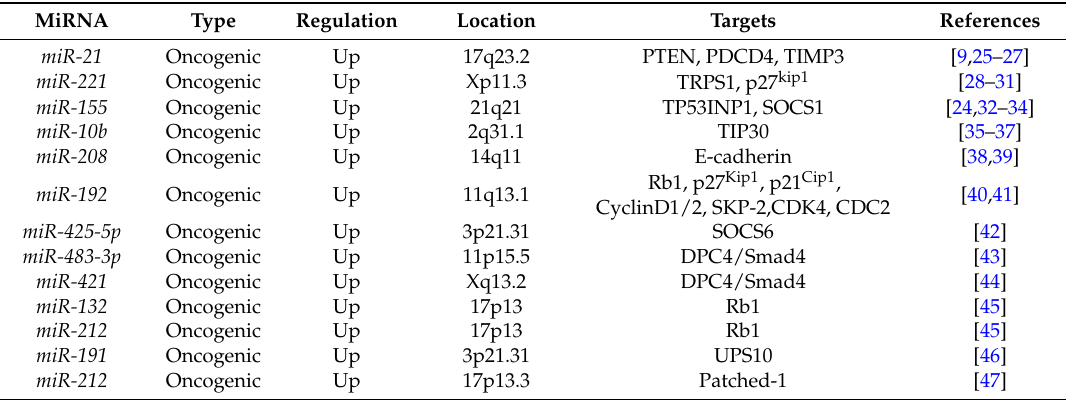
Table 1. Different oncogenic miRNAs in pancreatic